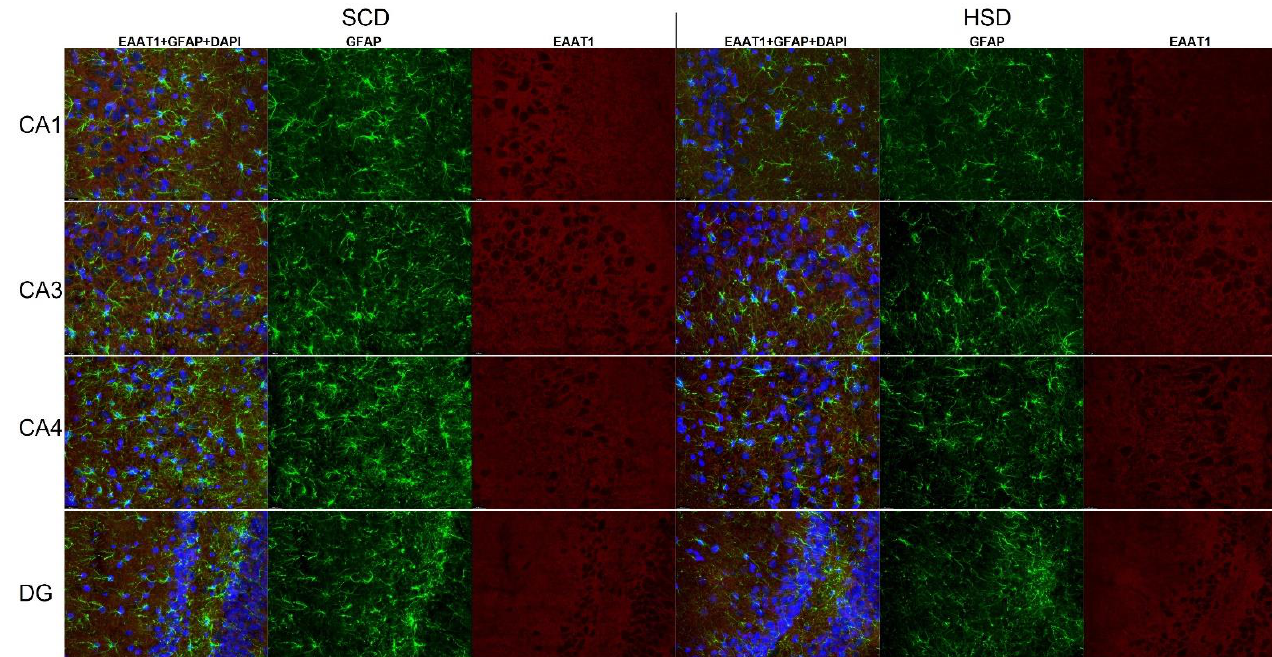
Figure 7. Immunohistofluorescence staining of EAAT1 localization on astrocytes in the mPFC of female offspring. Representative images showing EAAT1 immunoreactivity (red) in GFAP positive astrocytes (green) with DAPI-stained nuclei (blue). n = 6 in each group. Magnification × 40, scale bar 20 μm.